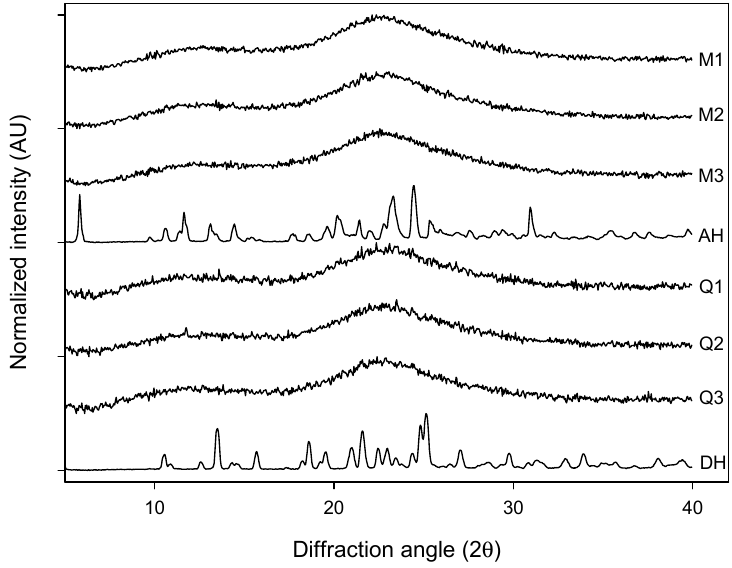
Figure 1. XRPD diffractograms of: milled samples (M1, M2 and M3), quench cooled samples (Q1, Q2 and Q3), crystalline anhydrate (AH) and crystalline dihydrate (DH).